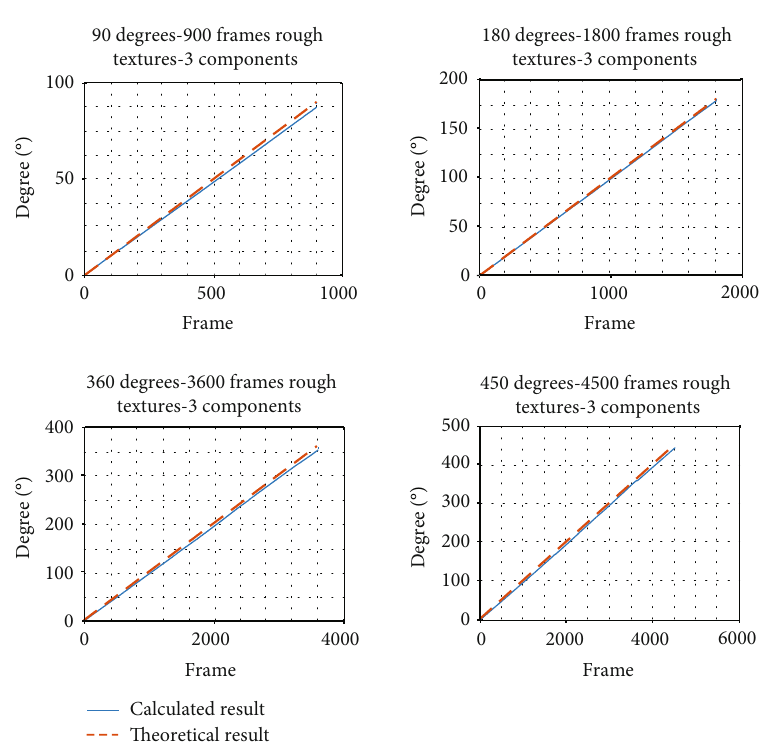
Figure 6: Angle estimation of model (b) under di ff erent rotation angles (10 frames per